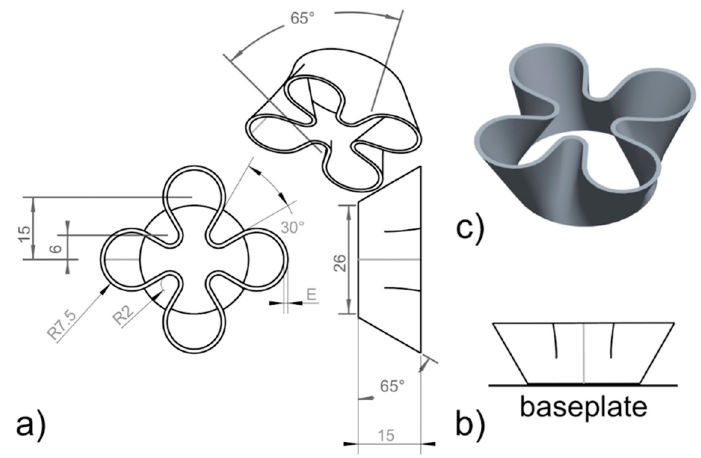
Figure 6. Recommended specimen geometry to be used for assessing thin-wall geometry: ( a ) model and dimensions; ( b ) positioning on baseplate; ( c ) 3D rendering.